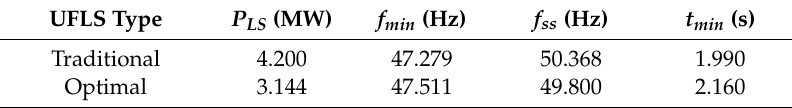
Table 4. Frequency quality metrics of high inertia—summer season scenario.